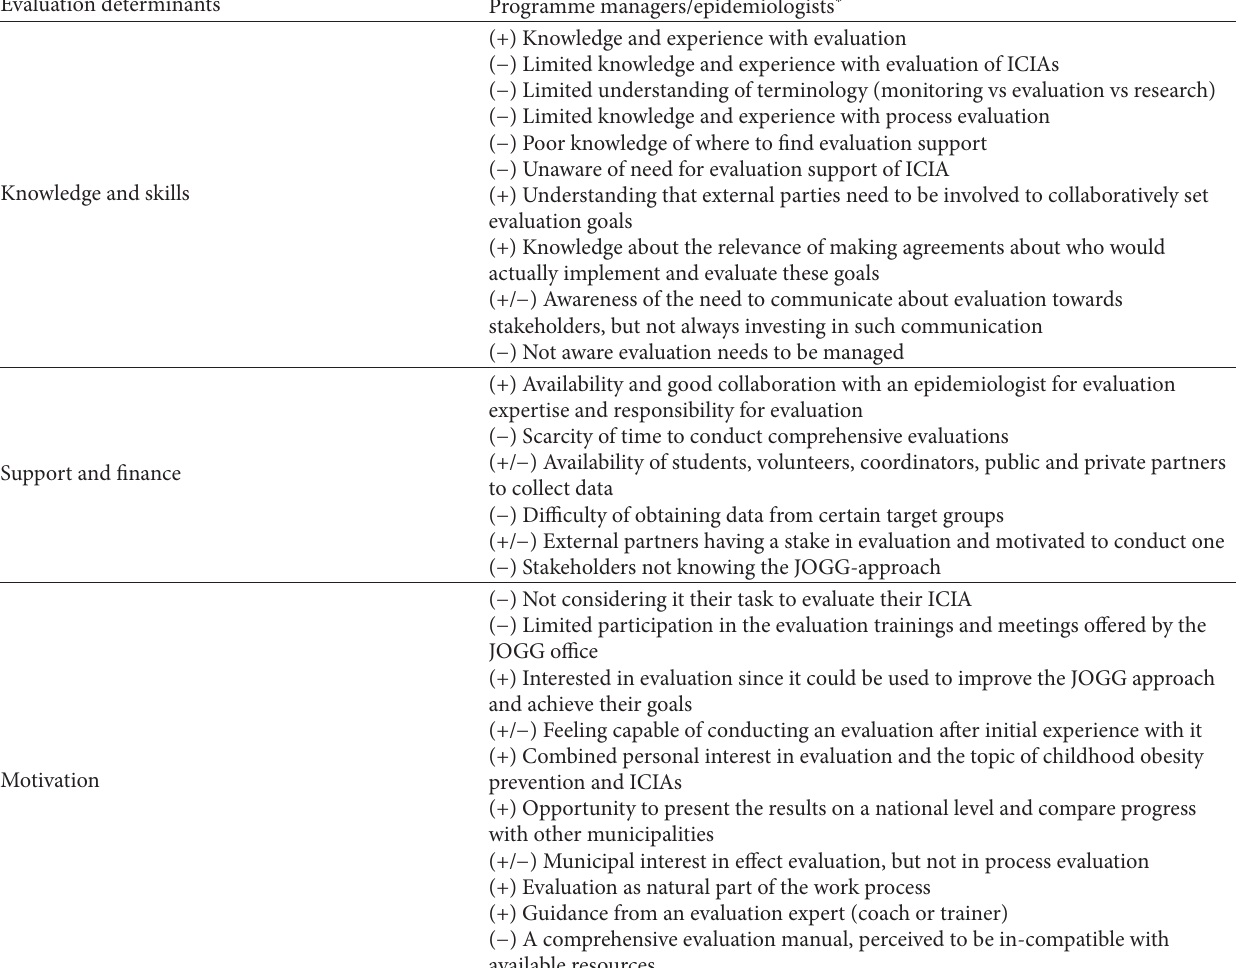
Table 2: Findings of this study described as factors in their preferred end